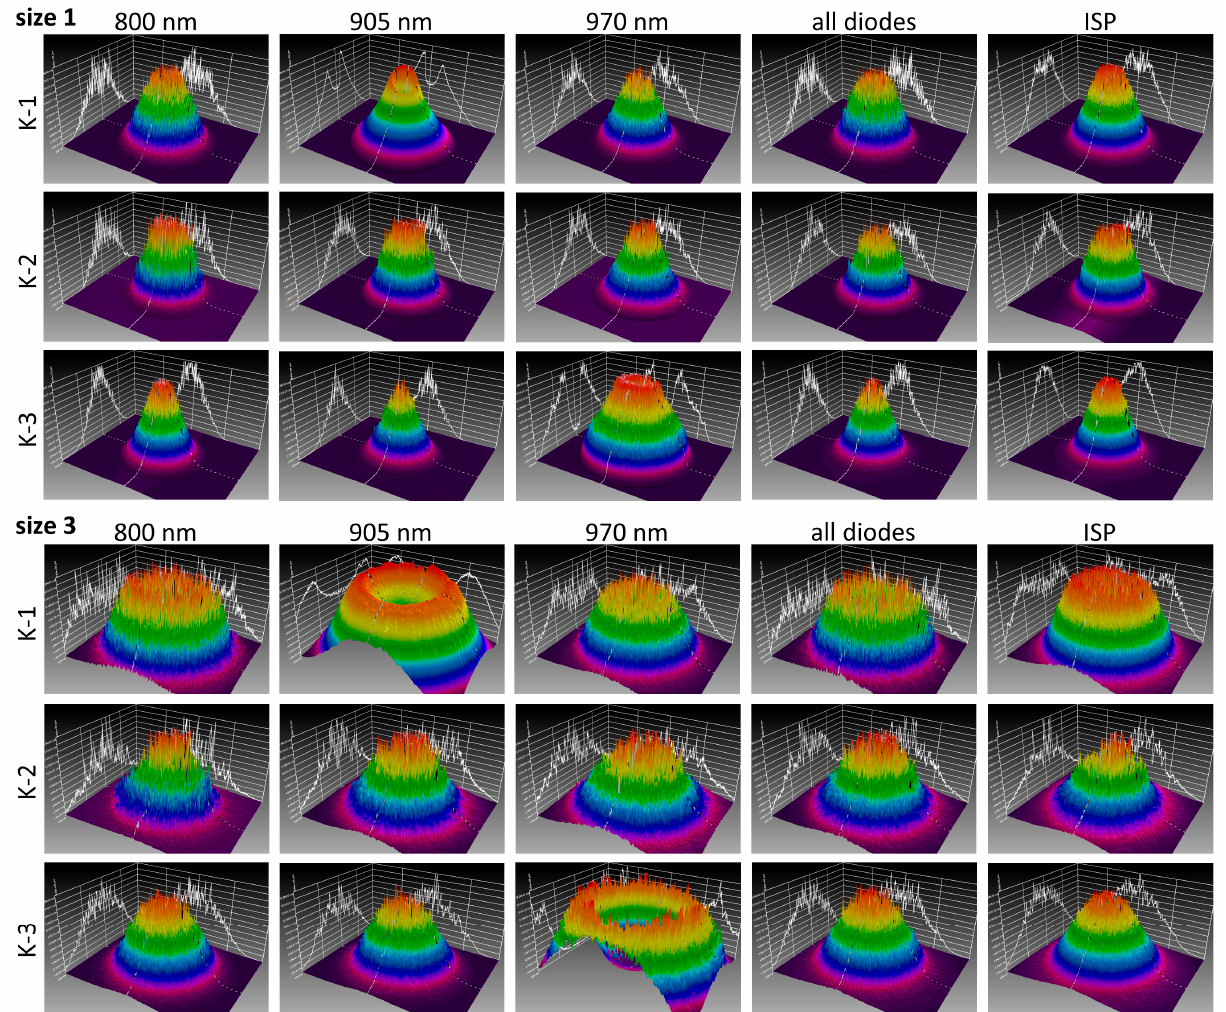
Figure 8. Color-coded light intensity distributions of the three K-lasers: for each unit, the three diodes (800 nm, 905 nm, 970 nm) were recorded individually as well as all diodes simultaneously and the K-lasers’ intense-super pulse (ISP) mode. Magenta represents the lowest light intensity, and red represents the highest light intensity. Projections of beam profiles along the horizontal and vertical axes are shown as white lines behind the intensity distributions. Recordings were taken with the K-lasers’ zoom objective set to sizes 1 and 3. The intensities of each recording were maximized by adjusting the camera exposure time.